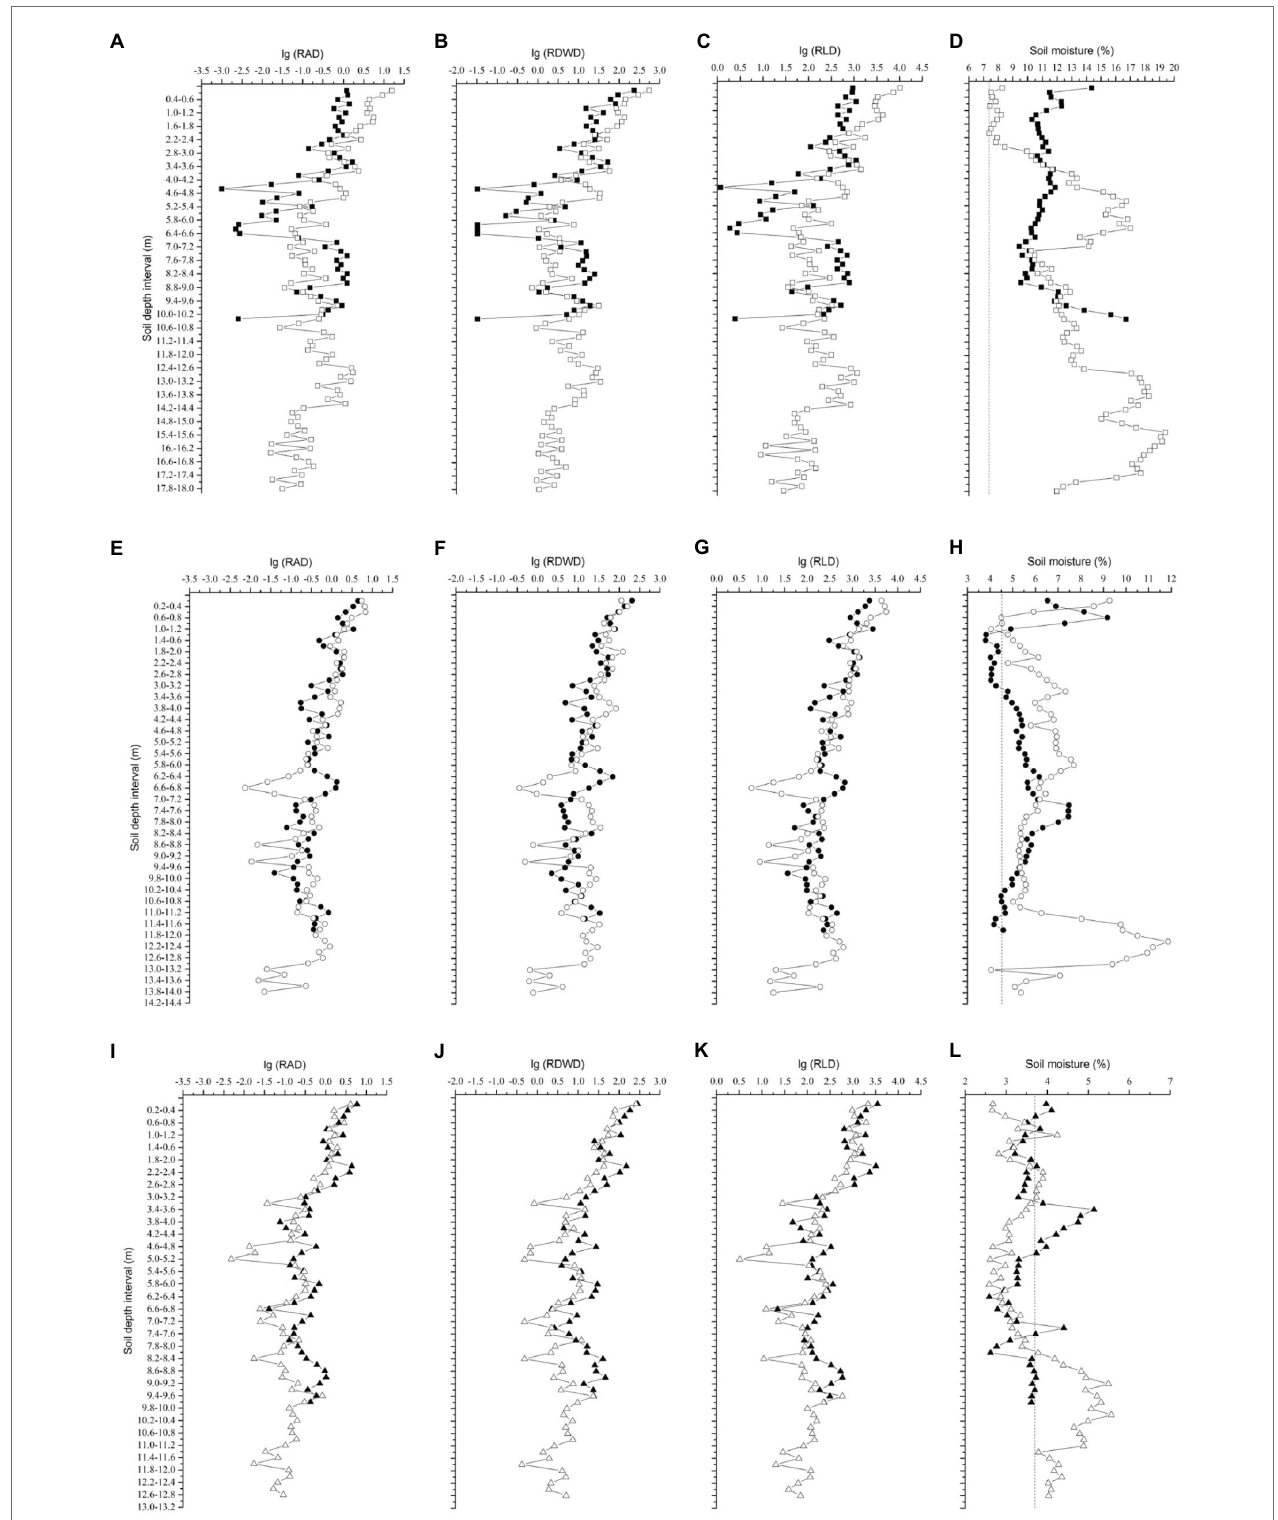
FIGURE 2 | Changes in RAD, RDWD, RLD, and soil moisture down to the root front with soil depth. RAD is the root area density (m 2 m − 3 ), RDWD is the root dry weight density (g m − 3 ), and RLD is the root length density (m m − 3 ). Dashed lines denote the wilting point at each site. Solid and empty rectangles, circles, and triangles represent northerly and southerly aspects at the sites Changwu (A,B,C,D) , Ansai (E,F,G,H) , and Suide (I,J,K,L) ,